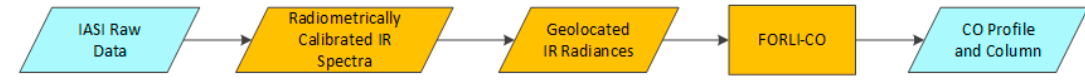
Figure 10 . QA4ECV formaldehyde (HCHO) product top-level traceability chain. CTM: chemical transport model.